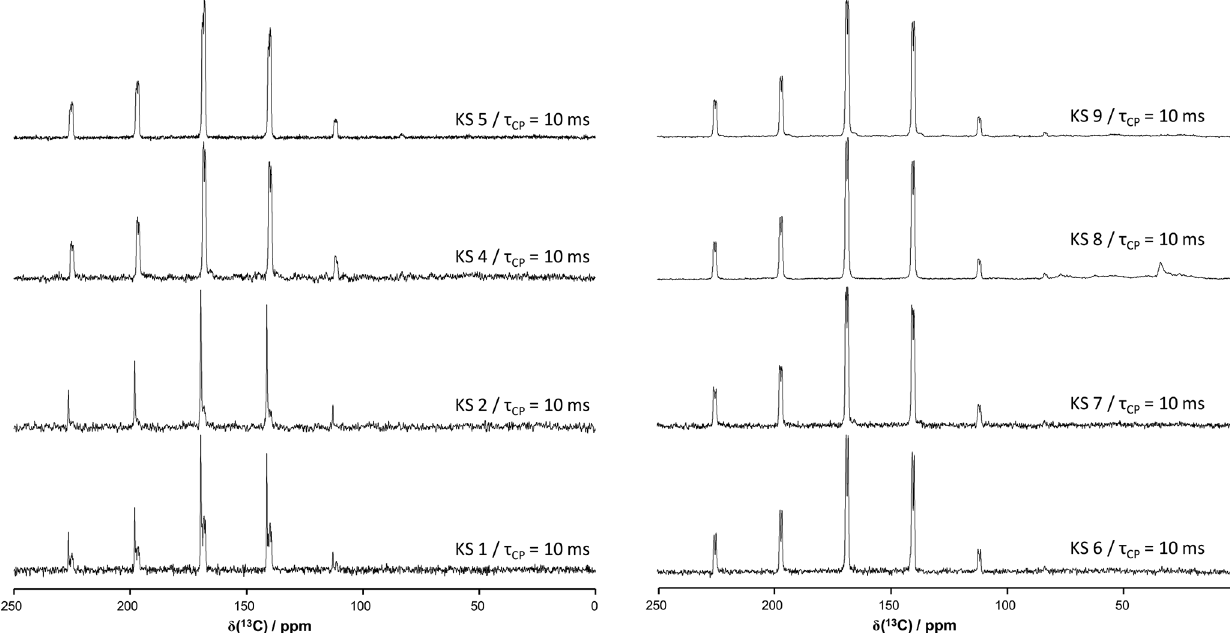
Figure A3. 13 C CP MAS NMR spectra of all KSs presented in this work (700MHz). The contact time in milliseconds is indicated system- atically.